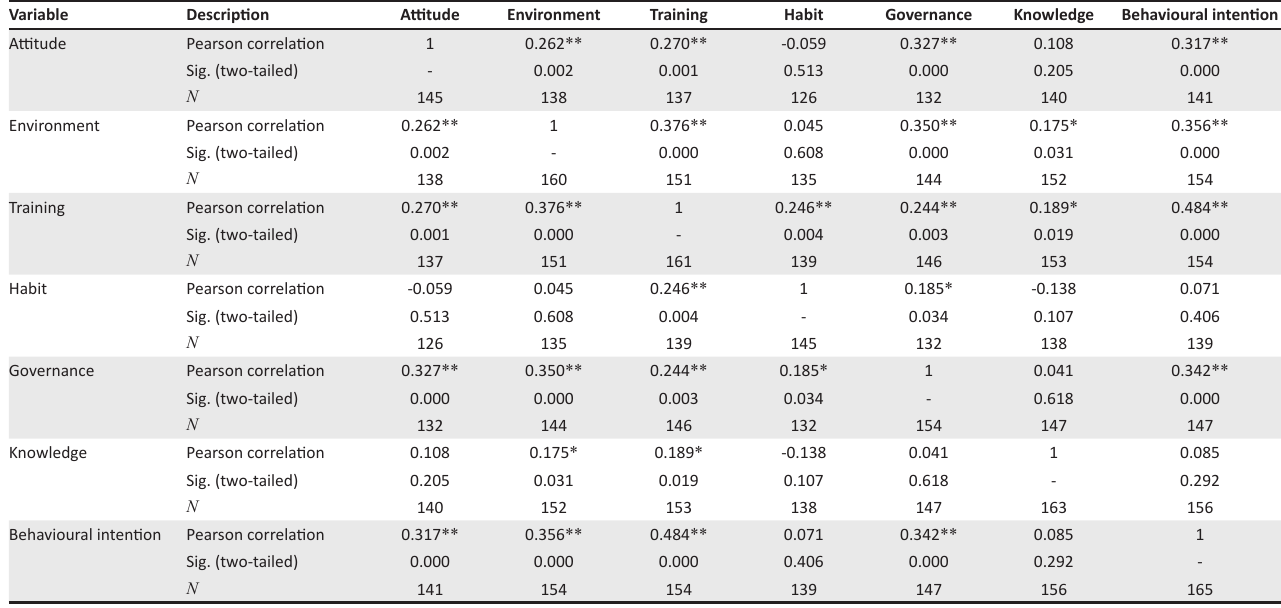
TABLE 4: Test of correlation between traits. Variable